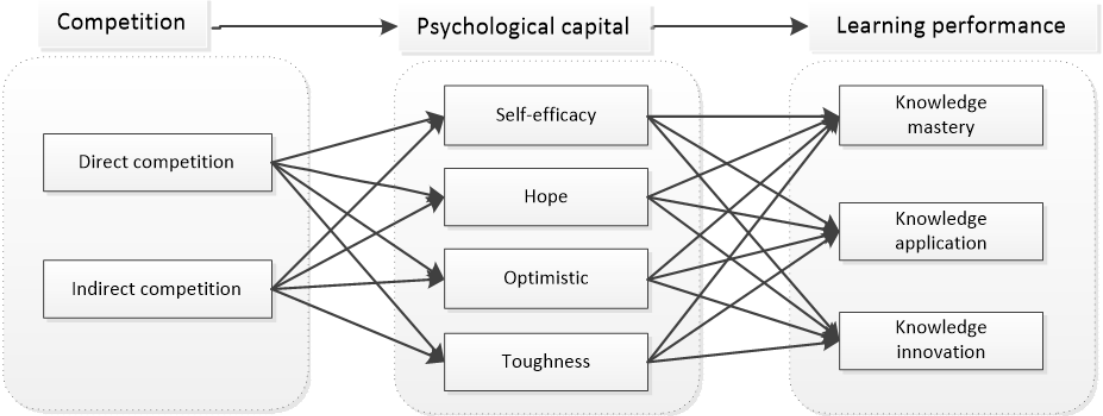
Figure 2. Mediation effect model of psychological capital.